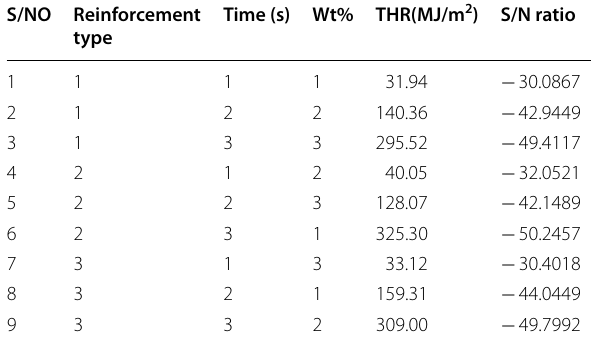
Table 7 Experimental design using L9 orthogonal array